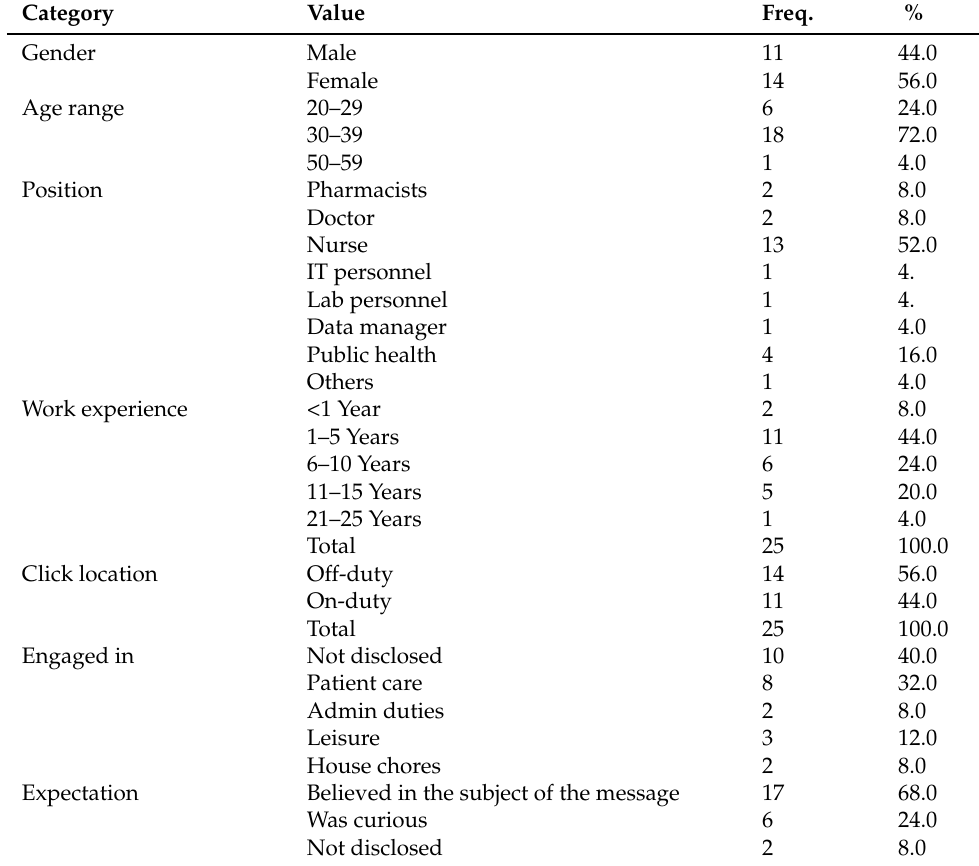
Table 4. Descriptive statistics of healthcare staff who clicked on the simulated malicious link and answered the